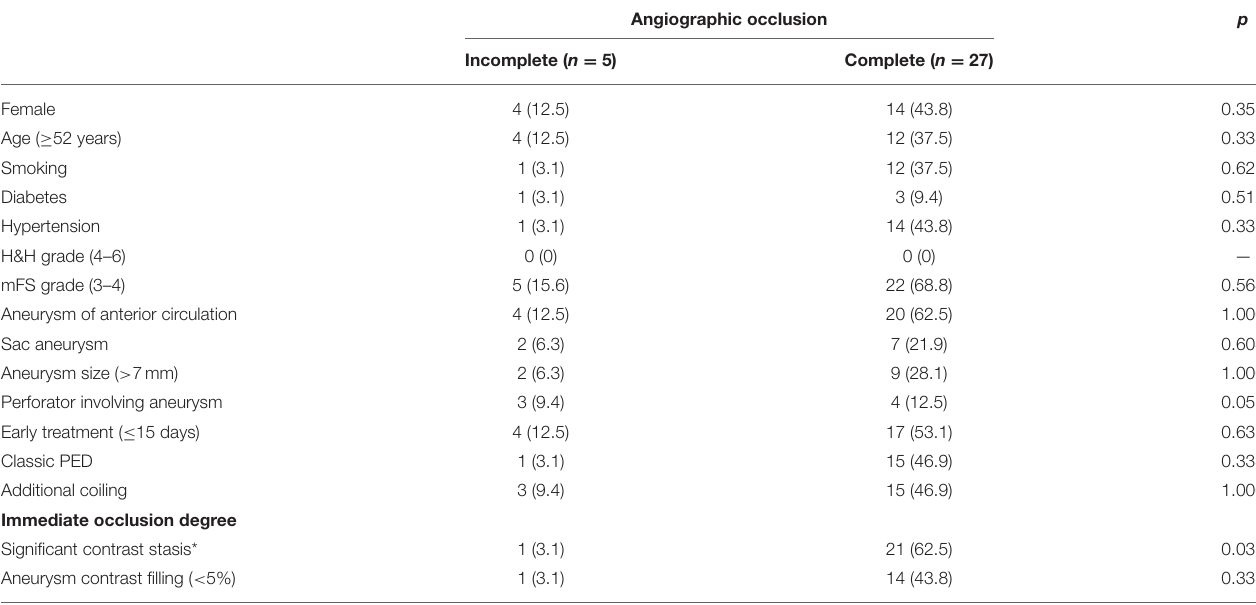
TABLE 4 | Factors associated with angiographic occlusion in cases with final follow-up angiography data